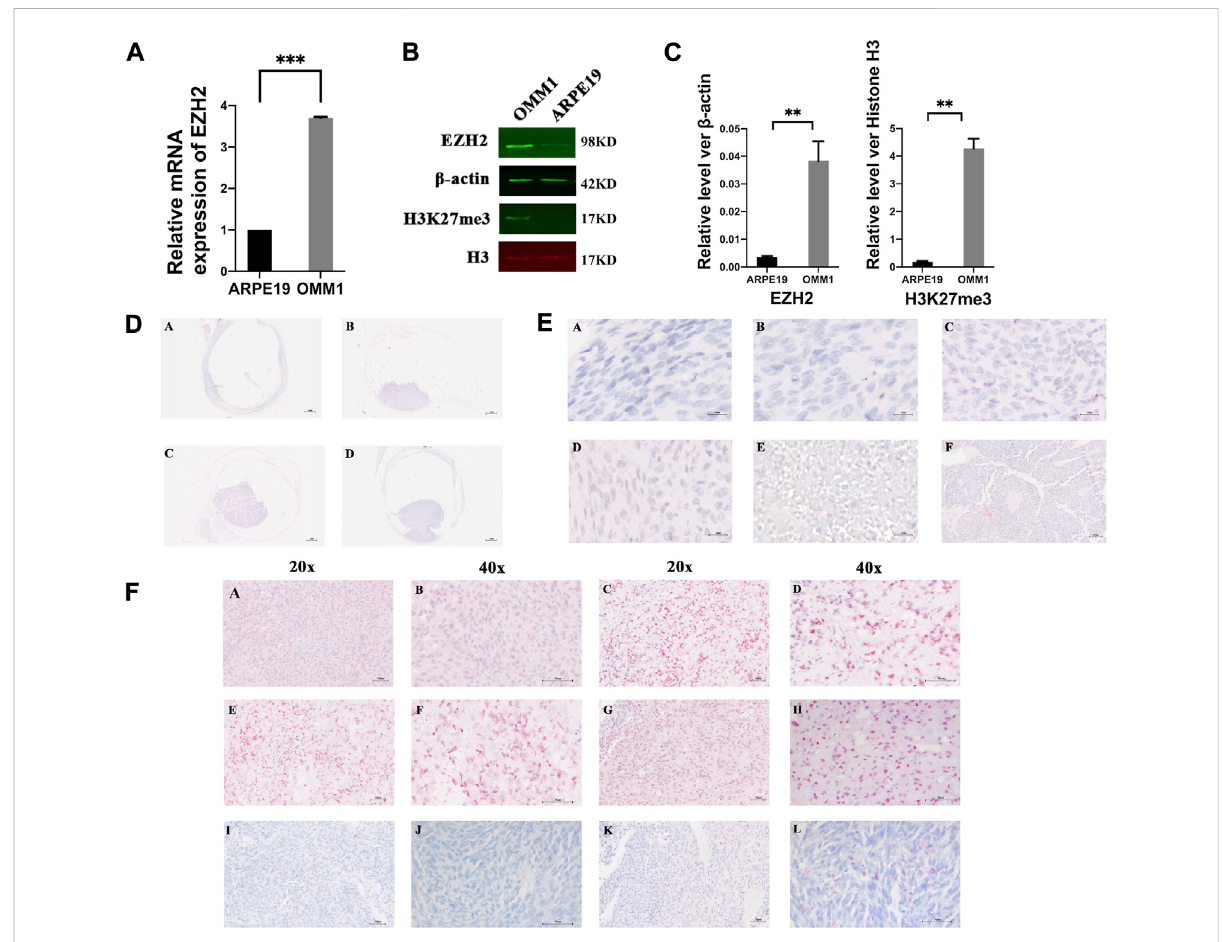
FIGURE 1 EZH2 and H3K27me3 were overexpressed in uveal melanoma. (A) Levels of EZH2 mRNA in OMM1 cells and ARPE19 cells. (B,C) Western blot analysis veri fi ed overexpression of EZH2 and H3K27me3 in OMM1 cells. The position and background of Histone H3 (680 nm, red) and H3K27me3 (800 nm,green)arethesame,andthe fl uorescenceintensityrepresentstheexpressionoftheprotein. (D) Fourkindsofshapesinuvealmelanoma.(a) fl at-shaped (b) half-dome-shaped (c) dome-shaped (d) mushroom-shaped. (E) Five kinds of cell types. (a) spindle A cell type (b) spindle B cell type (c) epithelioid cell type (d) mixed cell type (e) necrosis type (f) Homer-Wright rosettes (F) EZH2 and H3K27me3 expression by immunohistochemical staining (a – d) high EZH2 expression; (e – h) high H3K27me3 expression; (i,j) low EZH2 expression; (k,l) low H3K27me3